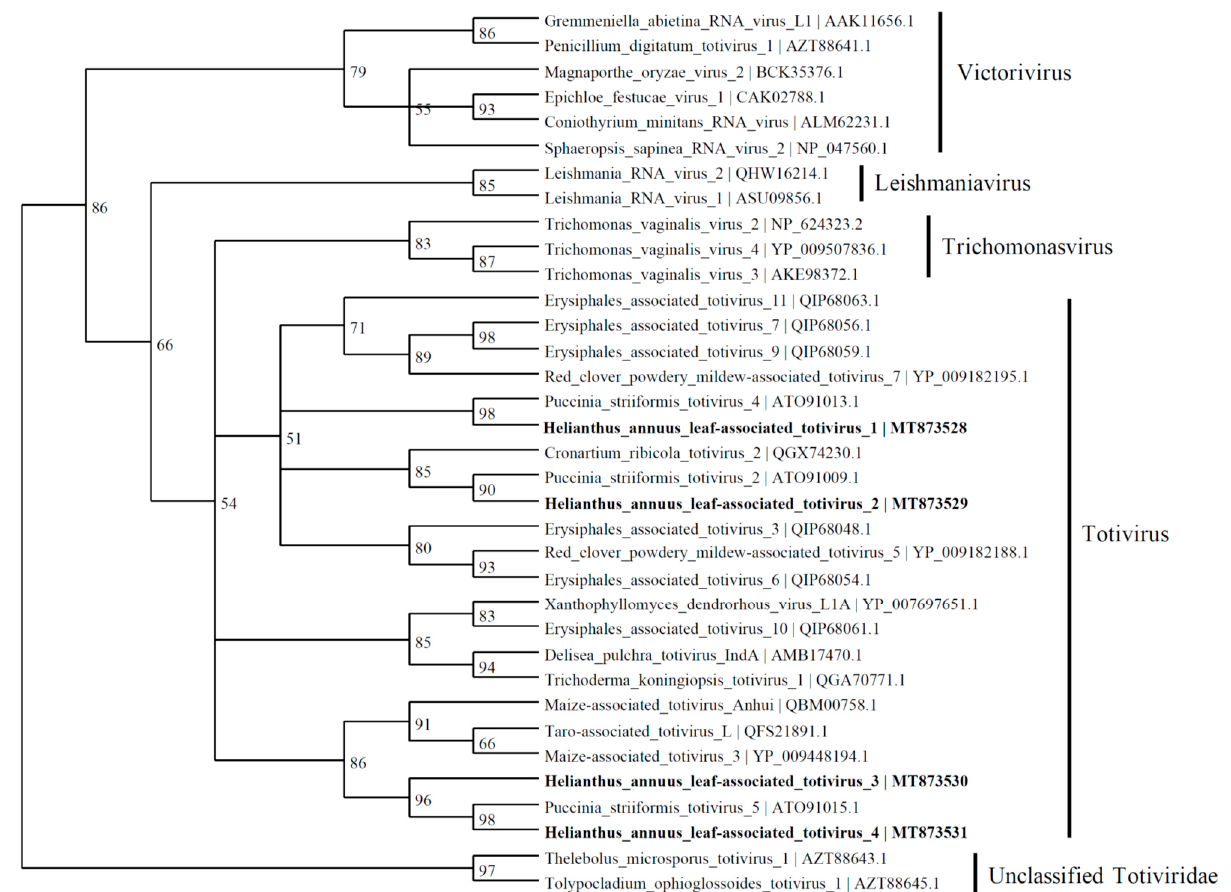
Figure 6. Phylogenetic tree depicting the relationships of the predicted amino acid sequence of the RNA-dependent RNA polymerase of Helianthus annuus leaf-associated totivirus 1, Helianthus annuus leaf-associated totivirus 2, Helianthus annuus leaf-associated totivirus 3, and Helianthus annuus leaf-associated totivirus 4 with other confirmed and proposed members of the family Totiviridae .